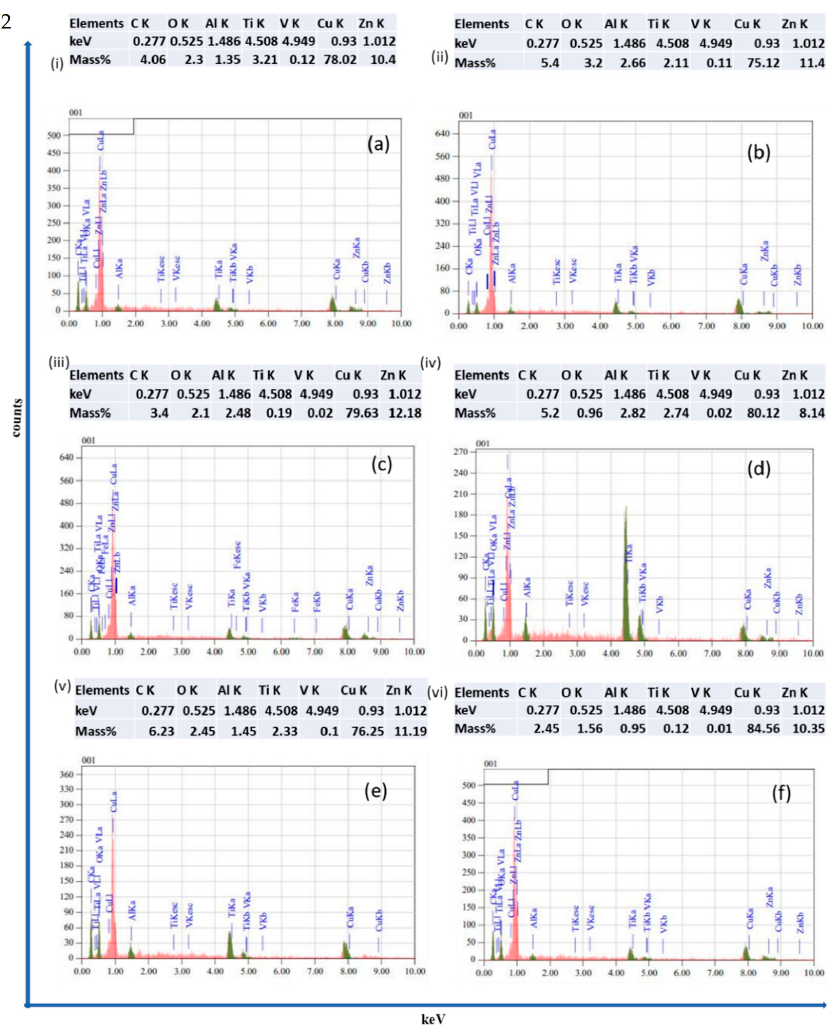
Figure 9. Chemical composition of EDC substrates for six experiments shown in the order of ( a ) to ( f )